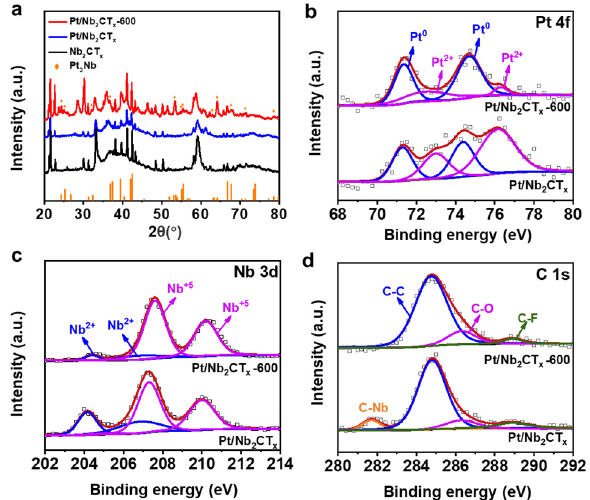
Figure 3. ( a ) XRD patterns of bulk Nb 2 CT x , Pt/Nb 2 CT x , Pt/Nb 2 CT x -600; ( b – d ) Pt 4f, Nb 3d, C 1s XPS spectrum of Pt/Nb 2 CT x and Pt/Nb 2 CT x -600